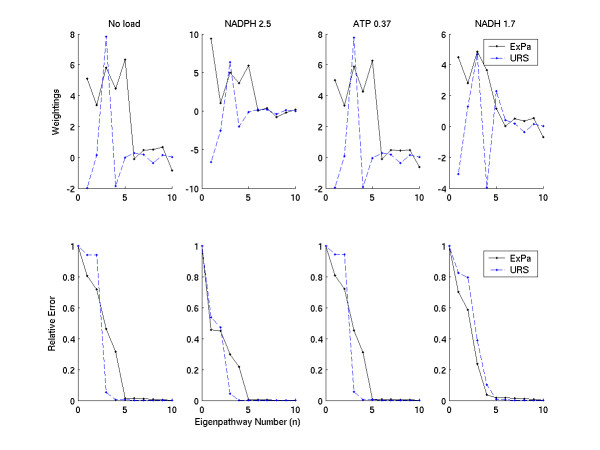
A comparison of how the eignpathways and PRMs reconstruct four different physiological flux distributions in the hRBC. The upper plots show the mode weightings for reconstructing the flux distributions, and the lower plots show the relative error between the reconstructed and physiological flux distributions for increasing numbers of modes.